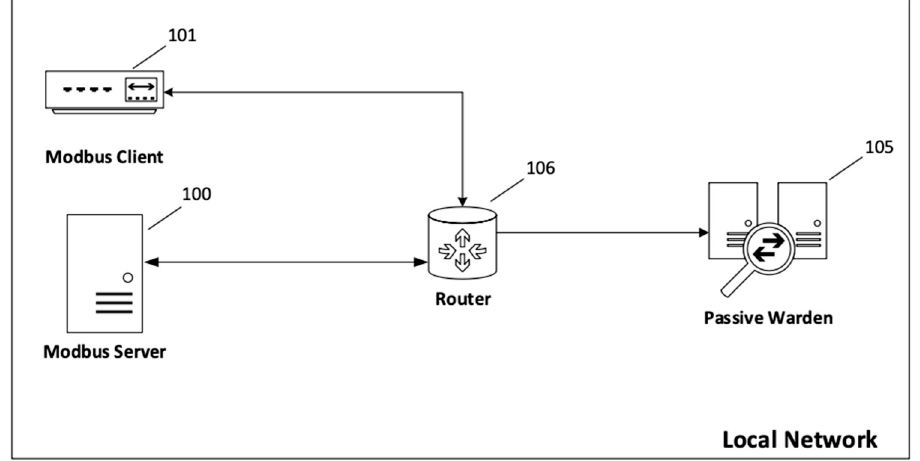
Figure 7. Two-endpoint testing architecture.